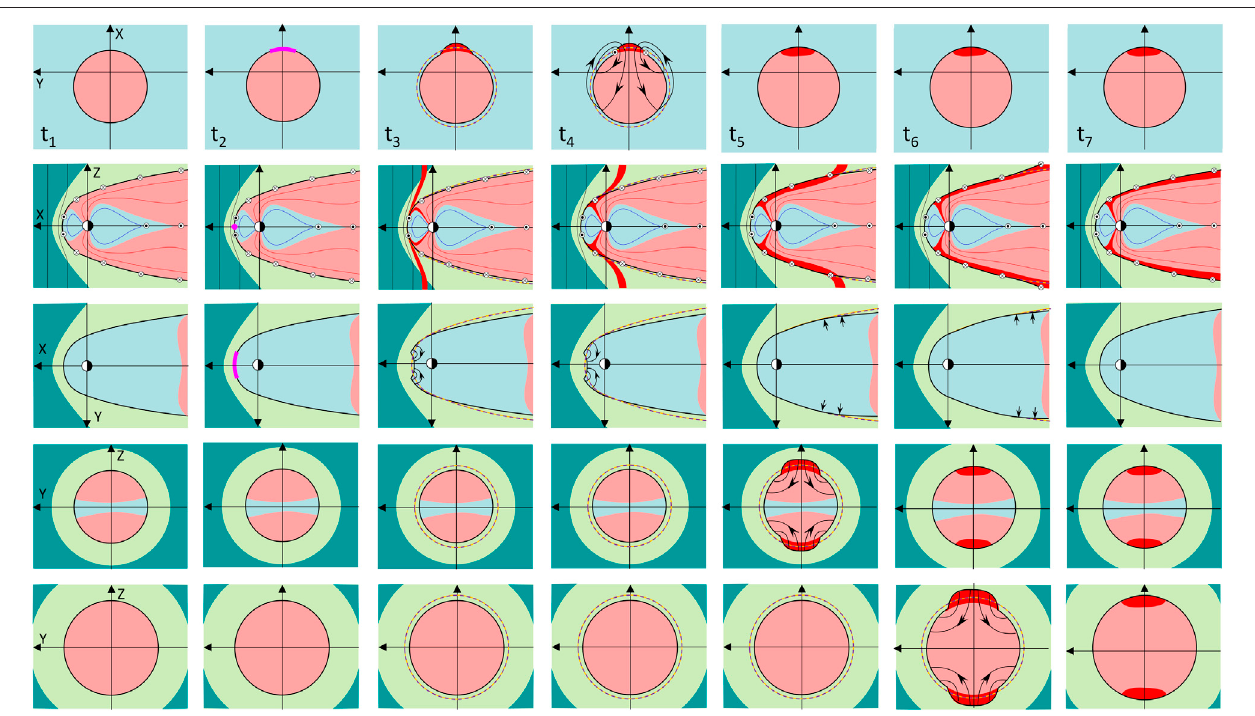
FIGURE 7 | Schematics of the expanding-contracting polar cap (ECPC) model predictions of the evolution of the magnetosphere-ionosphere system in response toanisolatedpulseofmagnetopausereconnection,generatingnewly-opened fl ux,showninred.Thecoloredregionsandlinesarede fi nedinthelegendto Figure8 .The sevencolumnsareforincreasingtimesfrom t 1 to t 7 .AxesintheGSMframearede fi nedintheleft-handplotforeachrow.Fromtoptobottomrowsshow:theionospheric polar cap looking down from above, the pink area being open fi eld lines and the pale blue being closed; the magnetosphere viewed from the dusk fl ank with dark green showing the undisturbed solar wind and light green showing the magnetosheath; the equatorial magnetosphere viewed from the north; the cross-section of the near-Earth tail viewed from downstream from the Earth; and the cross-section of the middle tail viewed from downstream from the Earth. Black lines with arrows show fl ows,mauvelinesanddotsanactivereconnectionsiteoritsionosphericfootpoint;mauveandorangedashedlinesshowtheequilibriumlocationoftheopen-closedand magnetopause boundaries for the amount of open fl ux. In some cases, this is not seen because the boundary in question is at its equilibrium location, in which case it is coveredbytheblacklinethatshowsthecurrentlocationoftheboundary.Inthesecondrow,themagnetopauseandcross-tailcurrentdirectionsareshown.Notethatat times t 5 and t 6 intheequatorialplane(row3)onlyshortarrowsareusedtodenotethe fl owsassociatedwiththetail fl aringincreasein,respectively,themidtailand(atthe later time) thefurthertail. Thatisbecause,asshown forthemid-tail crosssection attime t 5 (row4.column 5)and forthefurthertailcross section attime at time t 6 (row5, column 6), these fl ows originate at higher latitudes in both lobes and only descend into the equatorial plane close to the